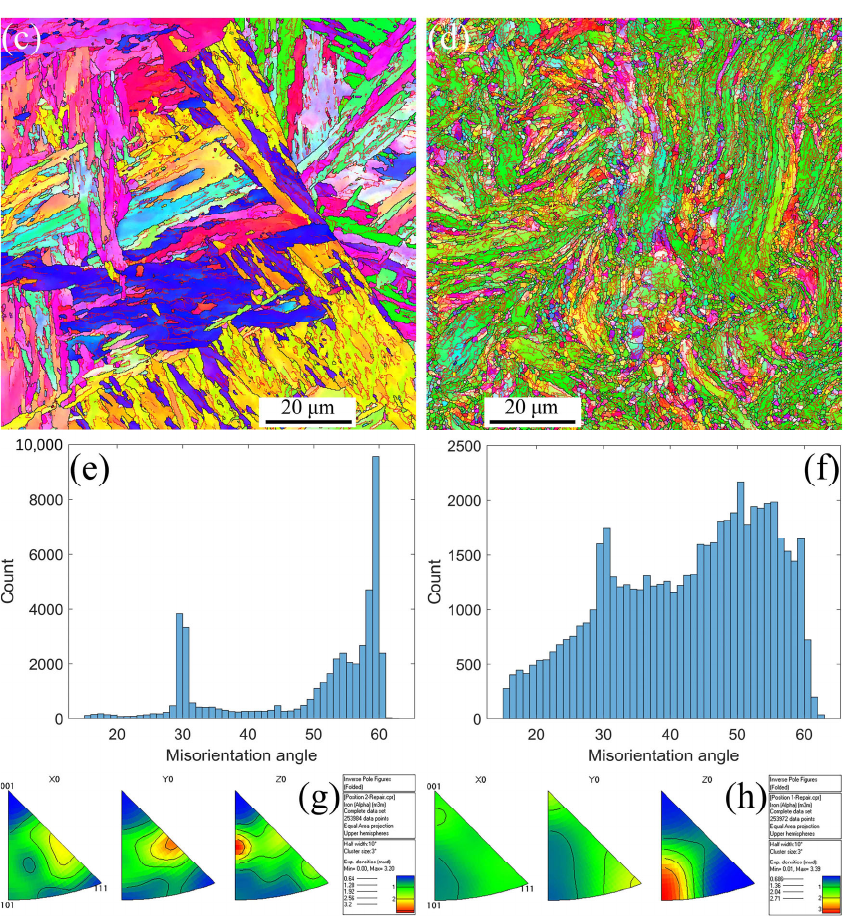
Figure 12. EBSD maps under different strain gradients at the strain rate of 5 × 10 − 5 s − 1 under 630 ◦ C (Red arrows indicate voids within the grain and along the line, green arrows indicate shrinking microstructures, and yellow arrows point to voids and shrinking cracks). ( a , b ) IQs; ( c , d ) IPFs; ( e , f ) misorientation angles; and ( g , h ) inverse polo figures.